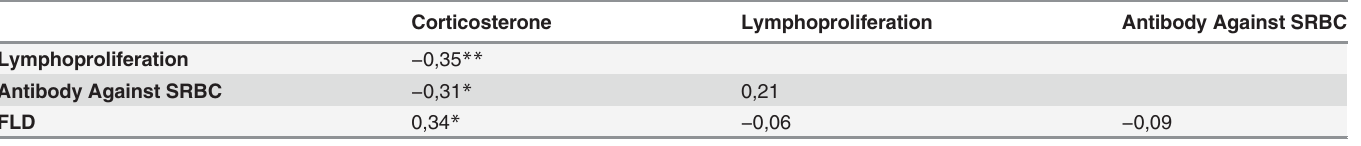
Table 1. Pearson correlation analysis between CORT and immunity